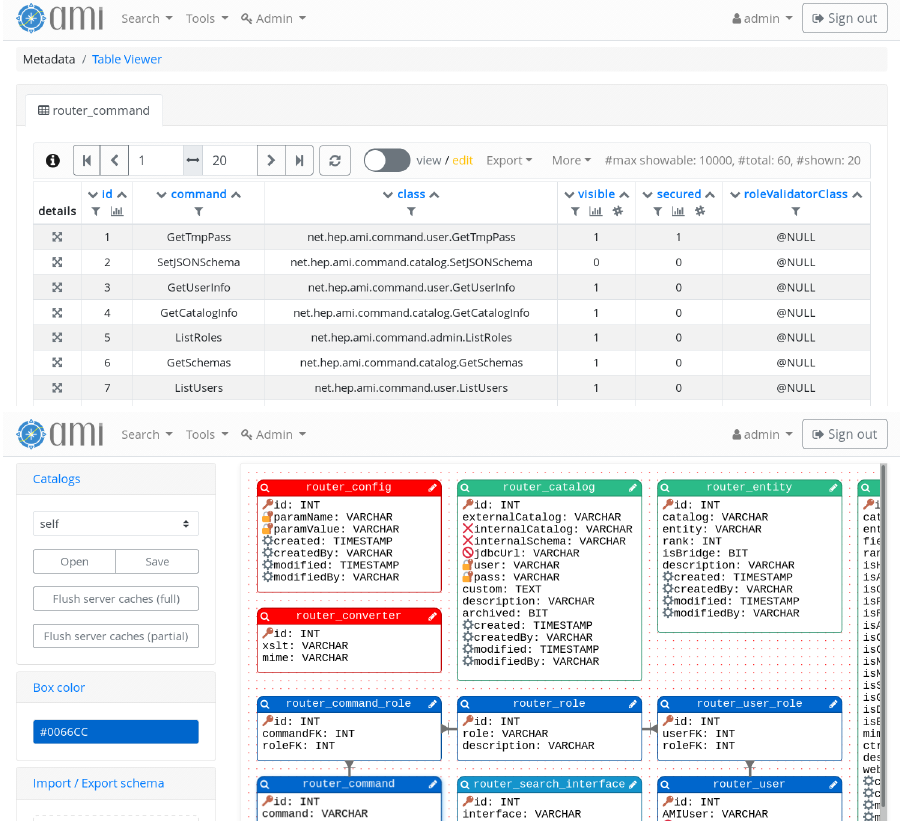
table viewer, simple search, criteria search, search interface